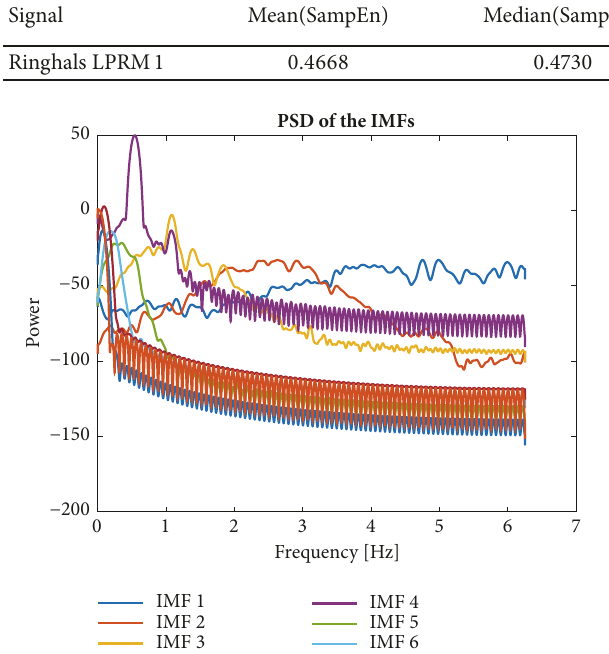
Figure 27: PSD estimate of the first 6 IMFs extracted from the analyzed segment.